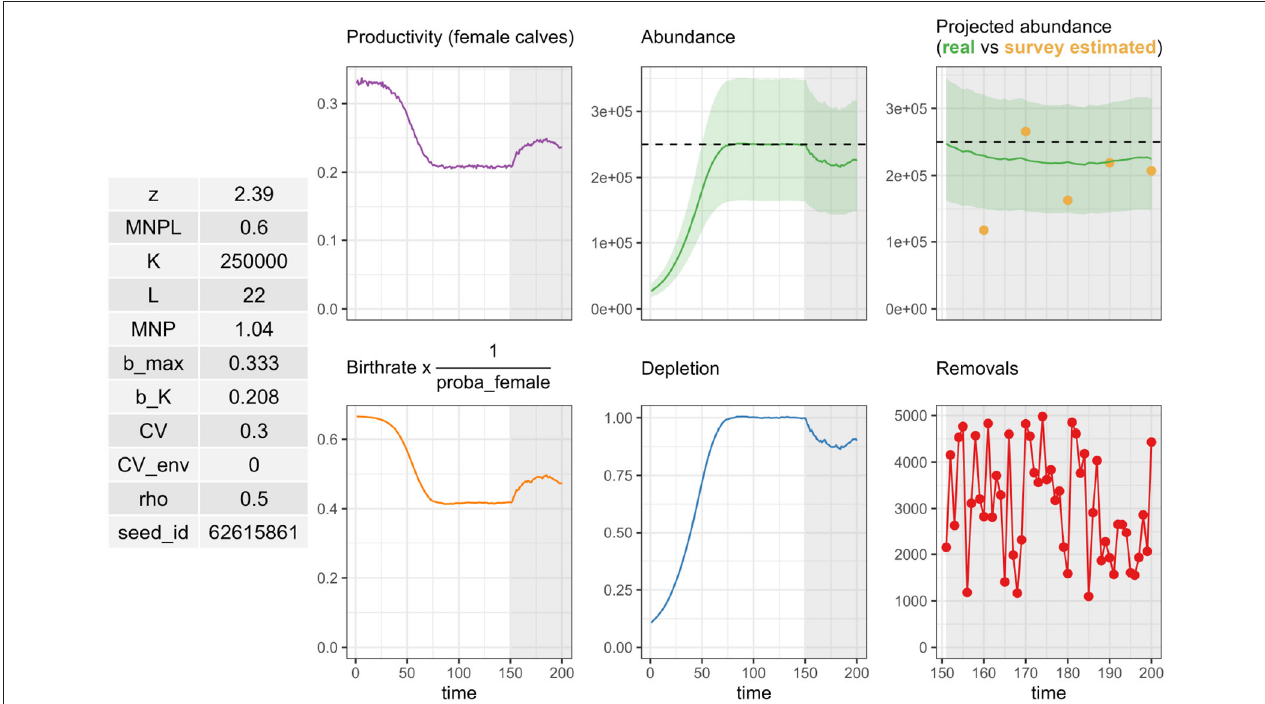
FIGURE 2 | Output from a call to summary_plot() on a pellatomlinson_rla output. Inputs are summarized on the left. Population dynamics are displayed in the middle, with either productivity and abundance (top) or birthrate and depletion (bottom). Simulated survey estimates (top) and removals are displayed on the right